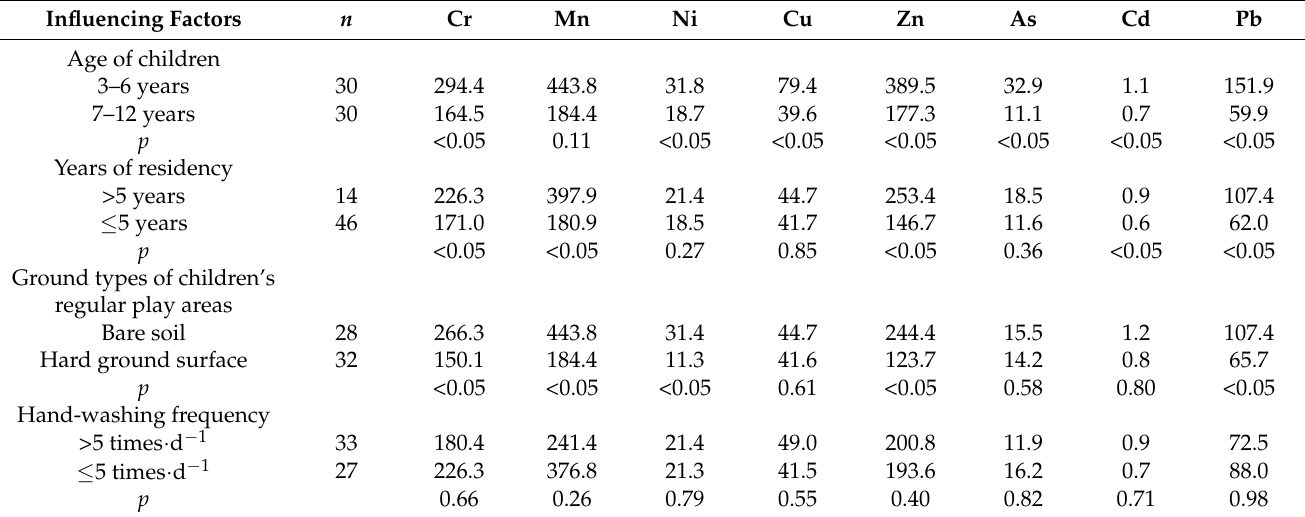
Table 3. Analysis of the influencing factors on metal levels in hand wipes ( µ g · m − 2 ).